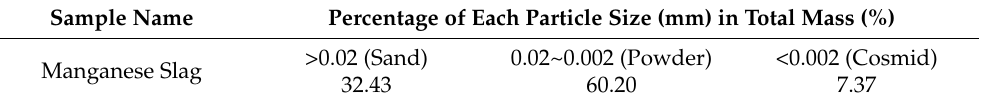
Figure 4. Particle size distribution curve of manganese slag. Table 4. Analysis of particle composition of manganese